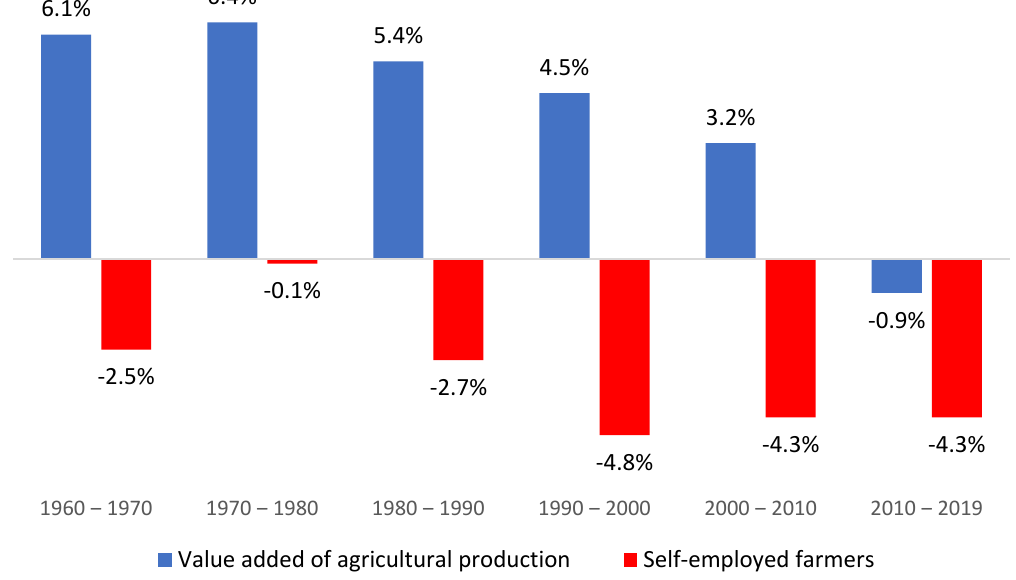
Figure 2. Changes in the value added of agricultural production and the number of self-employed farmers (percent).